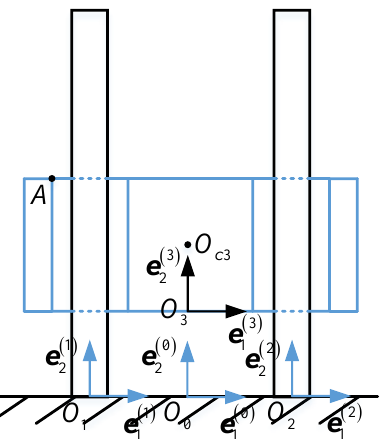
system relative to the inertial coordinate system and the deformation motion relative to the floating coordinate system, and the flexible guide bar and its floating coordinate system are shown in Figure 6.